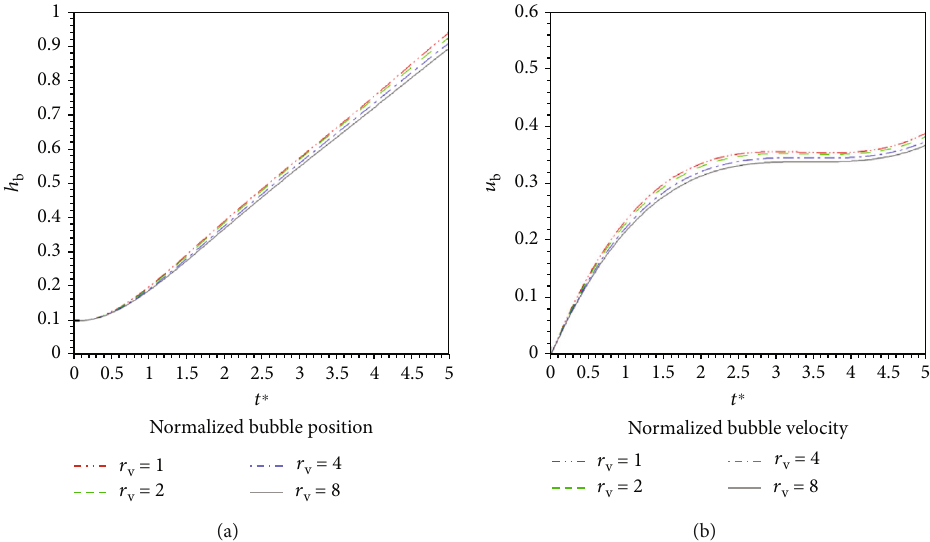
Figure 14: Temporal variations of the normalized bubble position and velocity for di ff erent viscosity ratios ( Re = 256 and At = 0 : 5 ).